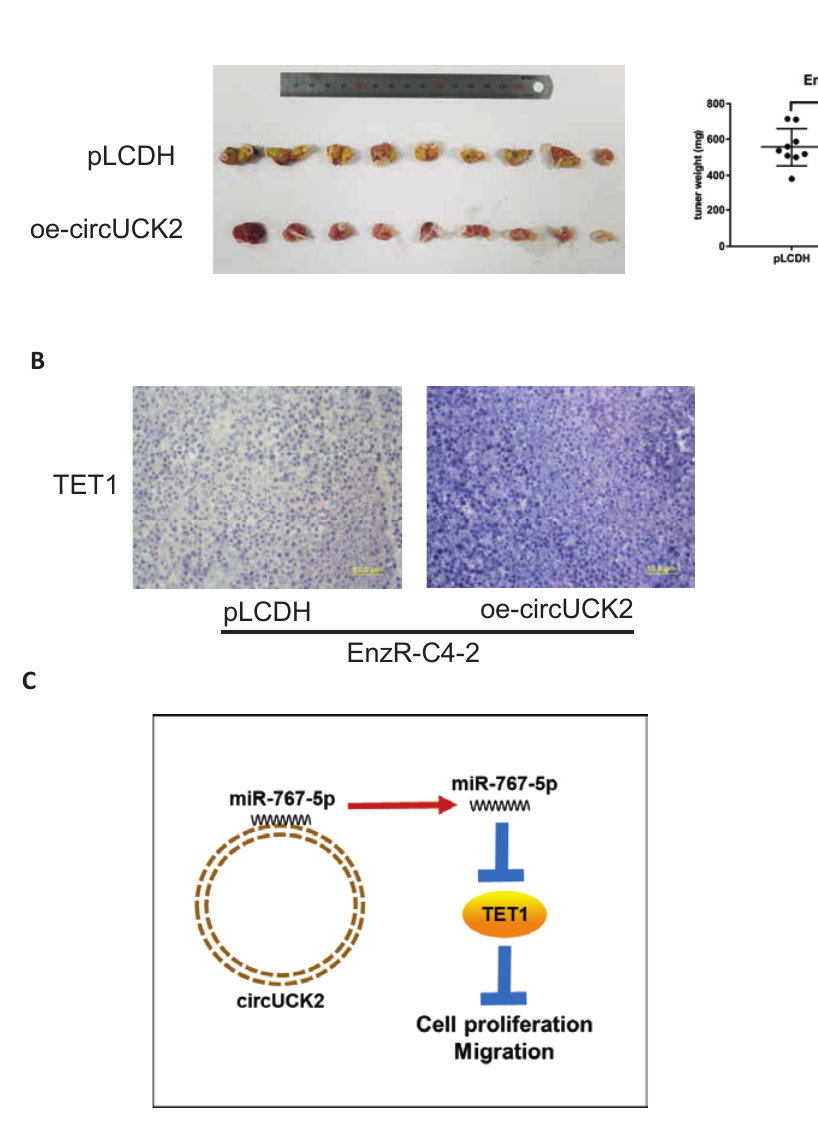
Figure 4: Preclinical study using the mouse model to prove that circUCK2 can inhibit the EnzR cell growth. (A) EnzR-C4-2 cells were trans- fected with pLCDH and circUCK2 and implanted into NDO/SCID mice. After 8 weeks, the tumour weights of the xenografts were tabulated and shown in dot plot. (B) The expression of TET1 in the two groups of mice. (C) Schematic of the circUCK2 pathway. The data shown repre- sent the mean of 9 NDO/SCID mice in each group. *p < 0.05 by Student’s t-test for two groups.